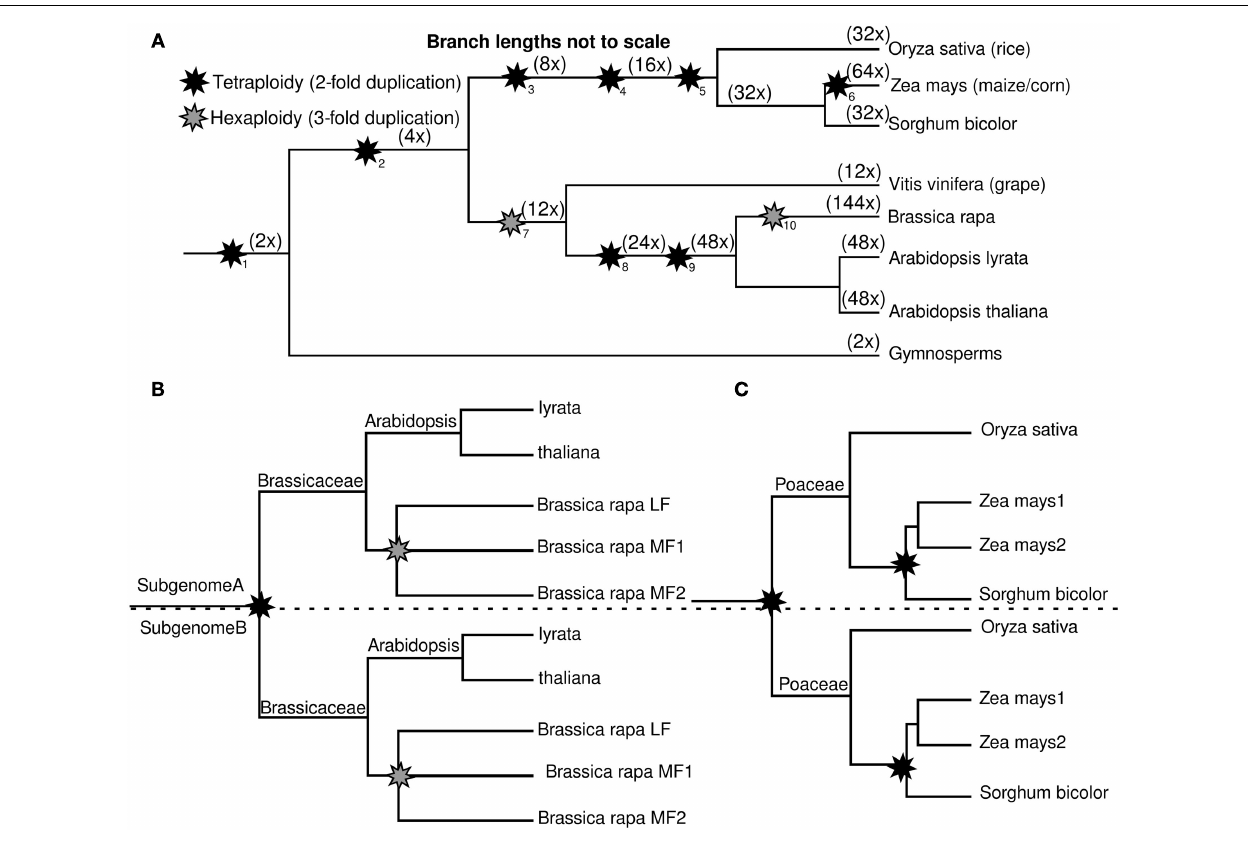
between the multiple subgenomes created by whole genome duplications within the crucifers.The LF, MF1, MF2 terminology for Brassica subgenomes comes fromThe Brassica rapa Genome Sequencing Project Consortium (2011). (C) The relationship between the multiple subgenomes created by whole genome duplication within the grasses.The Maize 1, Maize 2 terminology for maize subgenomes comes from Schnable et al.